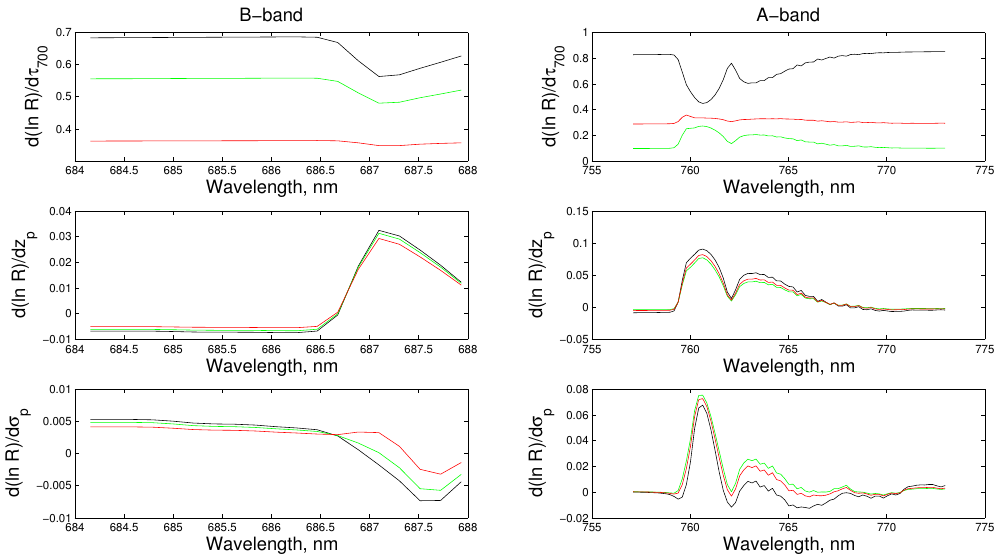
Fig. 4. Convolved Jacobian matrix representations for the black surface (black curve), high contrast surface (green curve), dark medium contrast surface (red curve). The top, middle and bottom panels show derivatives with respect to optical thickness τ 700 , peak height z p and peak width σ p ,